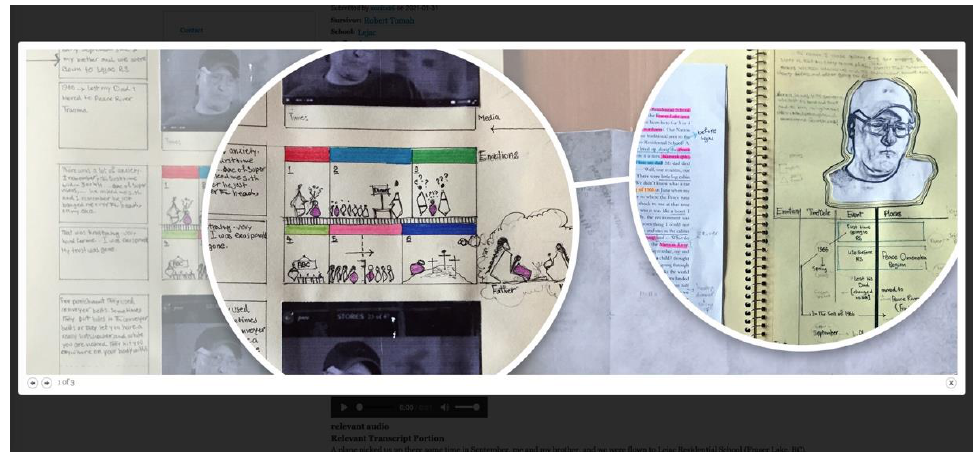
Figure 11. Screenshot of the Mapping Survivor Stories Map showing a full-screen view.